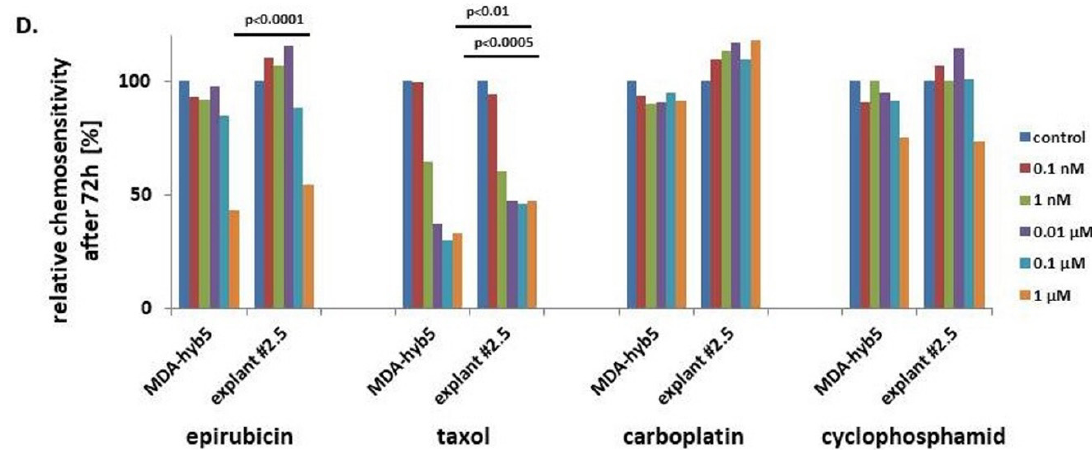
Figure 7. ( A ) MDA-MB-231 and MDA-hyb5 cells were treated with the indicated concentrations of taxol and epirubicin for 24 h to 72 h, respectively. Thereafter, the cells were lyzed and measured by fluoroscan assay. The data were normalized to the 24 h control cells. The relative data represent the mean ± s.d. of three independent experiments with three replicates each. Significance ( p ) was calculated by unpaired student’s t -test. ( B ) MDA-hyb5 cells and ( C ) explant cells from cultured MDA-hyb5-induced tumor #2.5 after dissection were exposed to different chemotherapeutic agents for up to 72 h. Untreated control cells (white bars on the left) were followed by the constant increase in drug concentrations between 0.1 nM and 1 µM (colored bars). After treatment with the corresponding drug at the indicated concentration and incubation time, the cells were lyzed and measured by fluoroscan assay. Data were normalized and relative fluorescence correlated to relative proliferative capacity as previously described [49]. Data represent the mean ± s.d. of three independent experiments with three replicates each. ( D ) Relative 72 h chemosensitivities for the different drug cytotoxicities were compared between MDA-hyb5 cells and explant cells from cultured mouse tumor #2.5 after dissection. Significance ( p ) was calculated by unpaired student’s t -test.